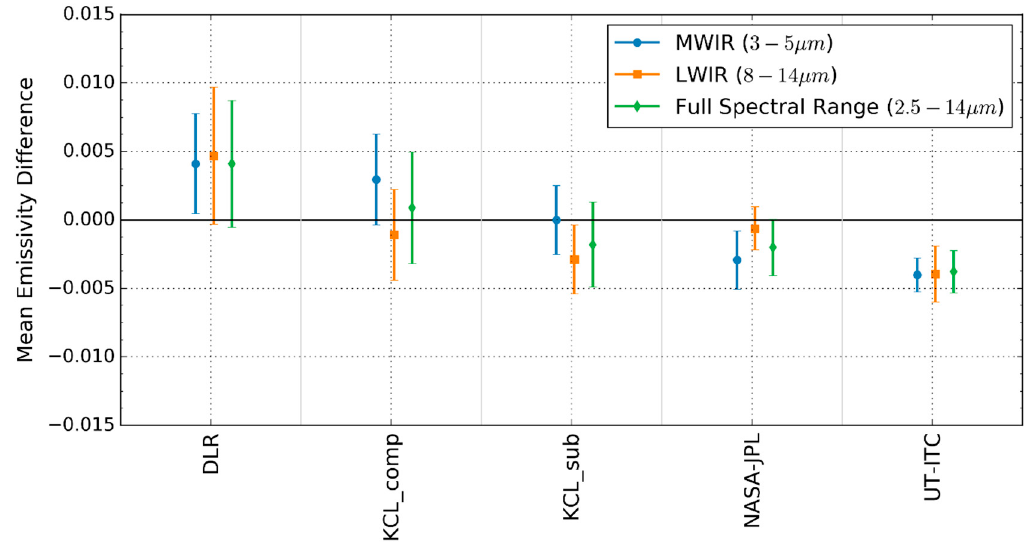
Figure 6. Spectral emissivity measurement differences between the spectra of distilled water from the ECOSTRESS spectral library and all measurements of distilled water aside from those from CSIRO. Differences ( Δε ) were calculated as Δε = ε − ε ESL where ε lab and ε ESL indicate the laboratory measurement and the ECOSTRESS spectral library spectrum respectively, before being averaged over specified spectral ranges. The bars are centred on the mean difference of that spectral range and have a half-length equal to the standard deviation of the difference over that spectral